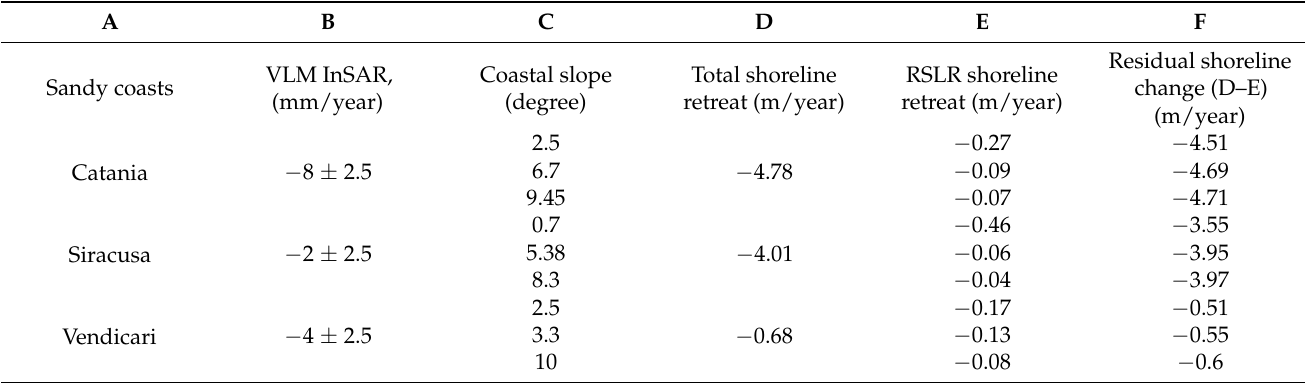
Table 3. Shoreline changes for different slopes (column C) for three sandy coasts located at Catania, Siracusa and Vendicari (Column A). The difference between the total observed shoreline retreat (due to the sea-level rise, the increasing intensity of extreme marine events, VLM and deficit on the sediment supply in a coastal system—column D) and the retreat due to RSLR only (column E, geometric horizontal retreat), defines the residual shoreline change (D–E). The coastal erosion triggered by RSLR is the predominant effect in the shoreline change process for the analysed gentle sloping sandy coasts which are retreating at up to 4.78